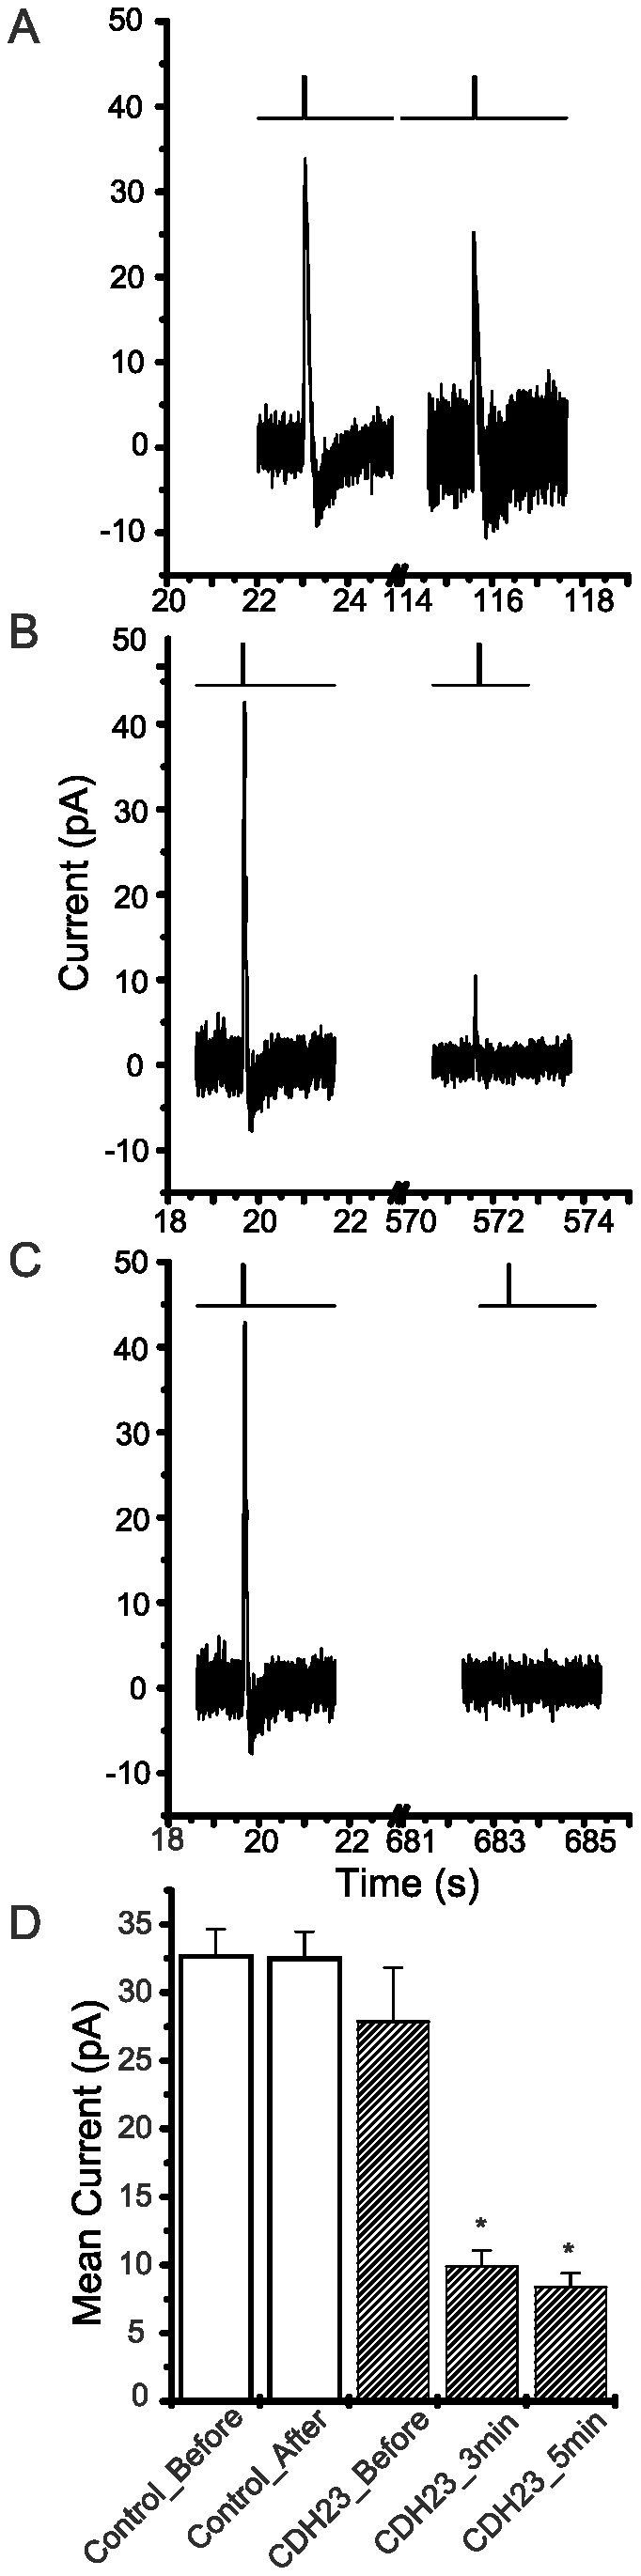
Effects of CDH23 peptides on the mechanoelectric responses induced by deflecting hair bundles.Hair bundles were deflected by pressure jets delivered by a nearby puffer pipette. Recording pipettes were attached to the plasma membrane adjacent to the base of the hair bundles. The TTL signal depicting the opening and closing the solenoid valve controlling pressure delivered to a puffer pipet is shown above representative traces depicting membrane current transients induced by hair bundle deflection. (A) Recordings are shown for a perfusion control before (left) and after perfusion of potassium-enriched seawater (right). (B) Recordings are shown before (left) and 3 min after the perfusion of potassium-enriched seawater containing 10 nM CDH23 peptide (right). (C) Recordings are shown before (left) and 5 min after the perfusion of potassium-enriched seawater containing 10 nM CDH23 peptide (right). (D) The mean peak membrane current induced by deflecting hair bundles was calculated and plotted for before and after perfusion (±SEM, n = 10). Perfusion controls (empty bar) had perfusion of potassium-enriched seawater only. The CDH23 peptide-treated specimens (hatched bar) were exposed to potassium-enriched seawater containing 10 nM CDH23 peptide (final concentration). The peak membrane current induced by deflecting hair bundles was measured at two sampling times after the perfusion, 3 min and 5 min, in the CDH23 peptide-treated specimens. Asterisks indicate significant differences in mean peak membrane current between before and after perfusion (p<0.05).